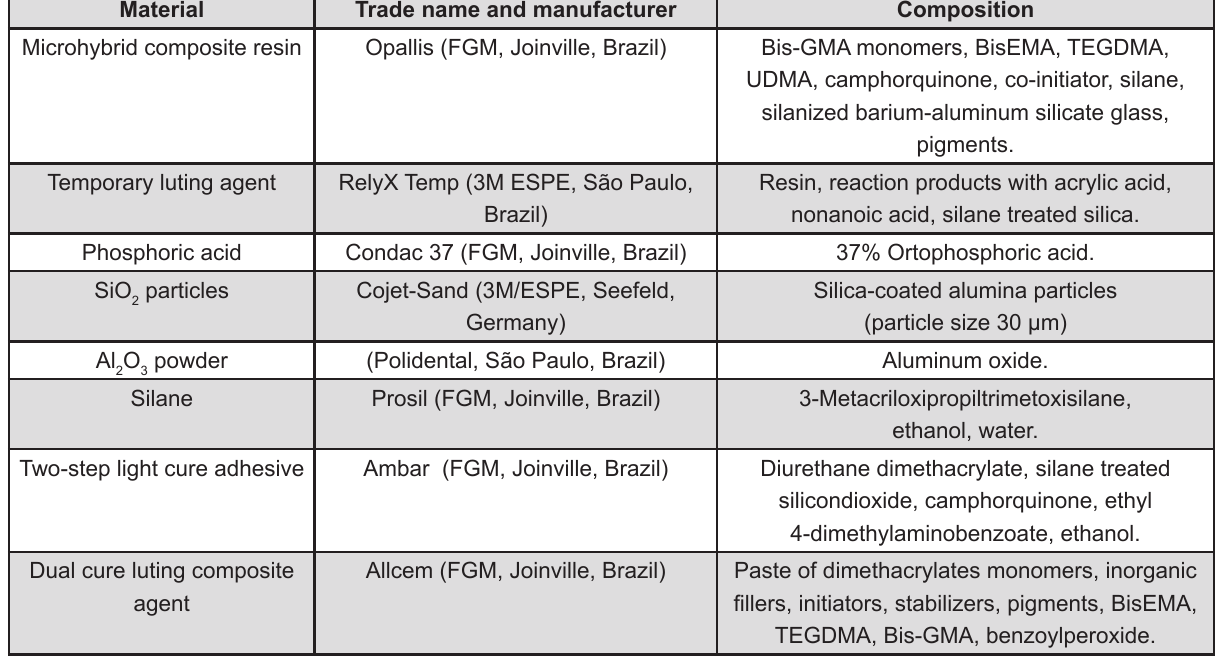
Figure 1- Materials used in the